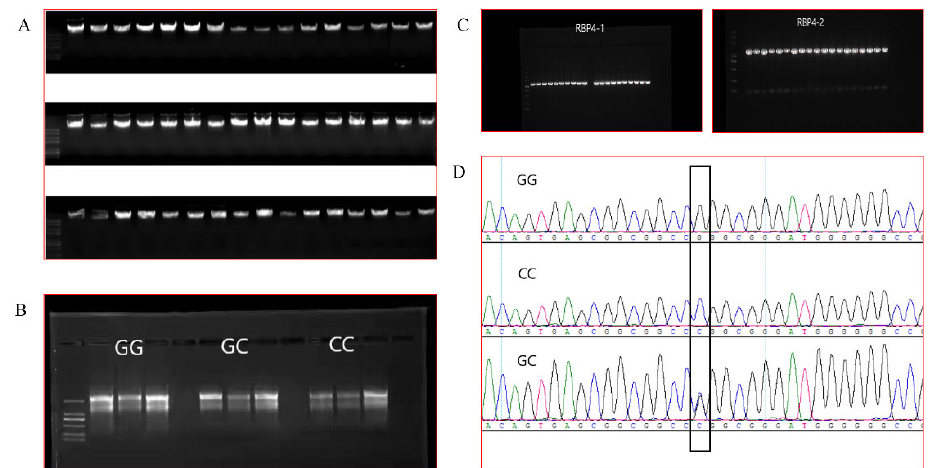
Figure 1. ( A ): Partial DNA electrophoresis results. ( B ): Electrophoresis results of total RNA from individuals of the three genotypes. ( C ): Electrophoresis results of PCR products. ( D ): Sequencing results for the RBP4 g.36491960G>C locus .